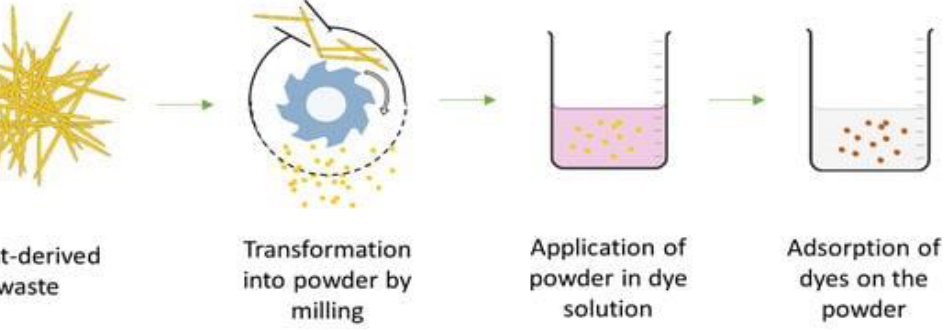
Figure 6. Anionic dye removal by plant-derived agricultural waste mechanical modification (adapted with permission from [100]).